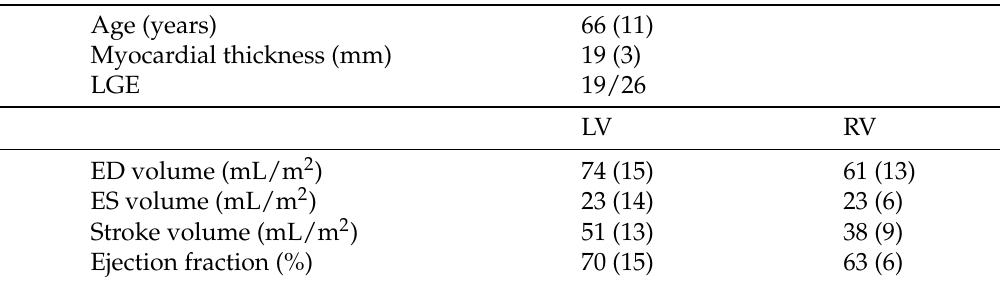
Table 1. Clinical and cardiac MRI-derived characteristics (mean (standard deviation)) of twenty-six patients with